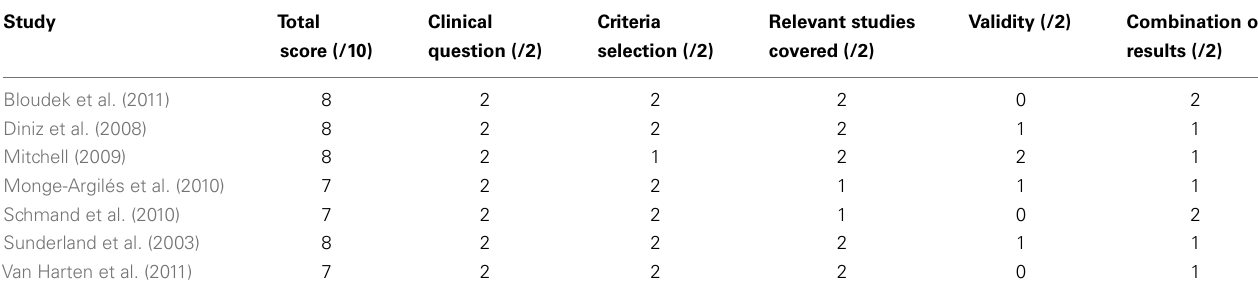
TableA4 | Methodological quality of selected systematic reviews with meta-analyses according to Oxman’s